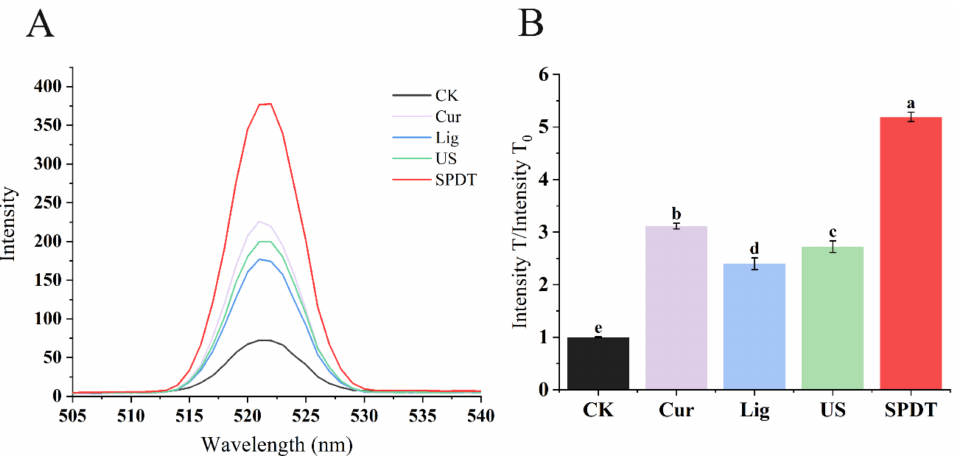
Figure 3. Generation of reactive oxygen species (ROS) in Listeria monocytogenes cells subjected